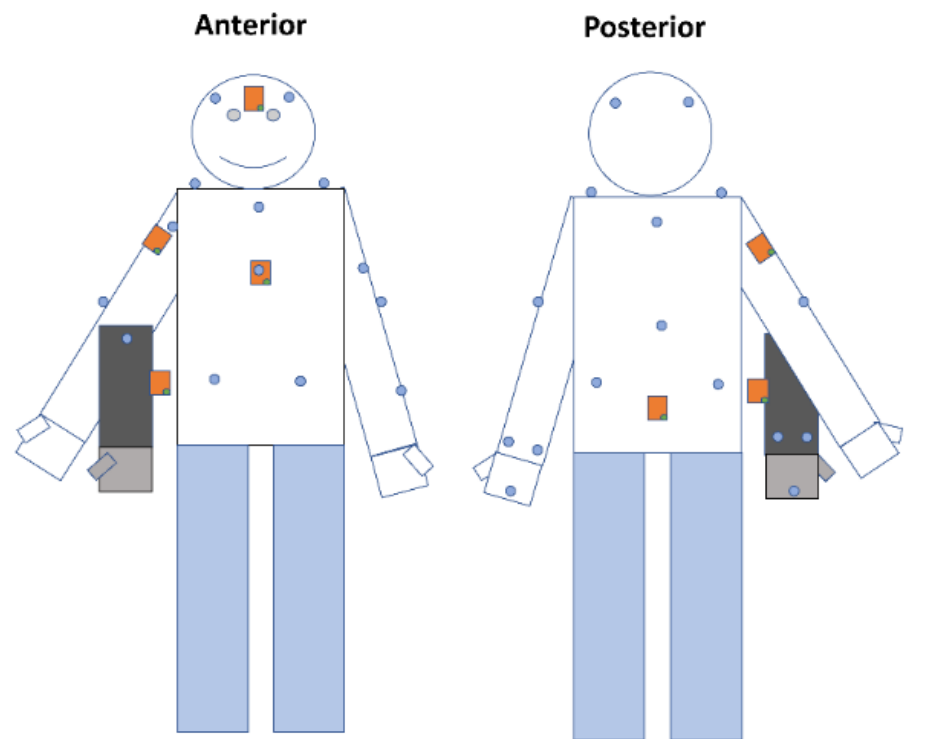
Figure A1. Illustration of sensor locations with the anterior view on the left and posterior view on the right. Orange boxes represent IMU sensors. Blue dots represent retroreflective markers. During the data cleaning and processing phase, review of the exported data showed that the markerless system’s software and background subtraction mechanism detected neither the retroreflective markers used by the optical system-based system nor the IMU sensors. The IMU sensors were not retroreflective and were not detected by the optical marker-based